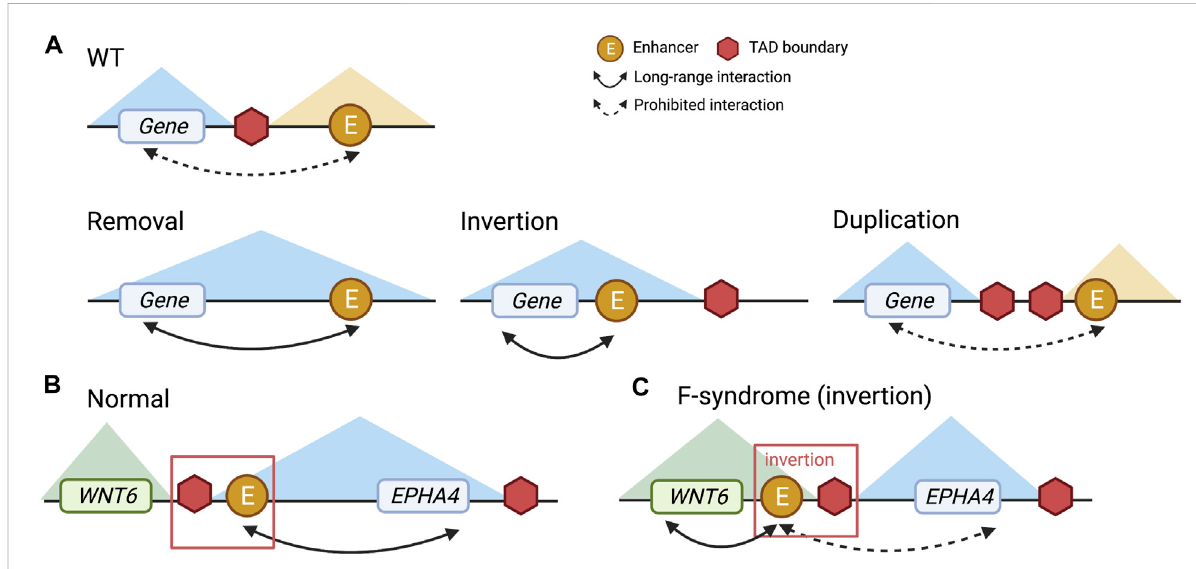
FIGURE 2 DifferenttypesofTADboundaryalterationandthe EPHA4 example. (A) Wildtype(WT),removal,inversion,andduplicationofTADboundary. (B) The normal status of TAD boundaries at the EPHA4 locus. (C) With an inversion genetic variant, aberrant TAD boundaries at the EPHA4 locus were observedinF-syndromepatients.TheenhancerandTADboundarytotheleftof EPHA4 areinverted,resultinginrepressionof EPHA4 expressionand activation of WNT6